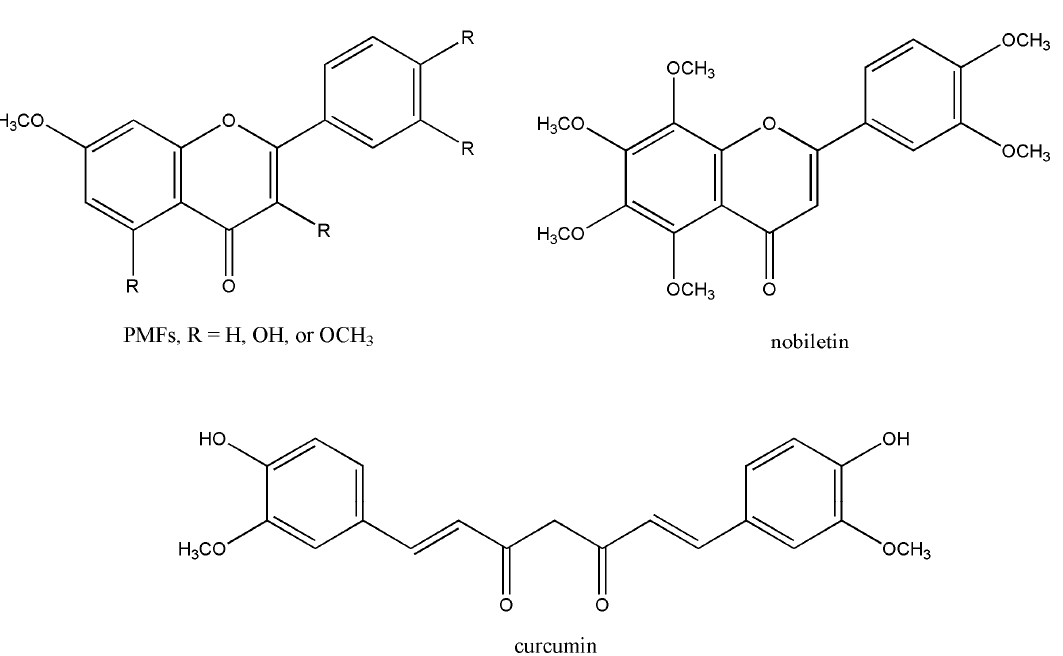
Figure 4. Molecular structures of polymethoxyflavones (PMFs) and other related natural compounds.